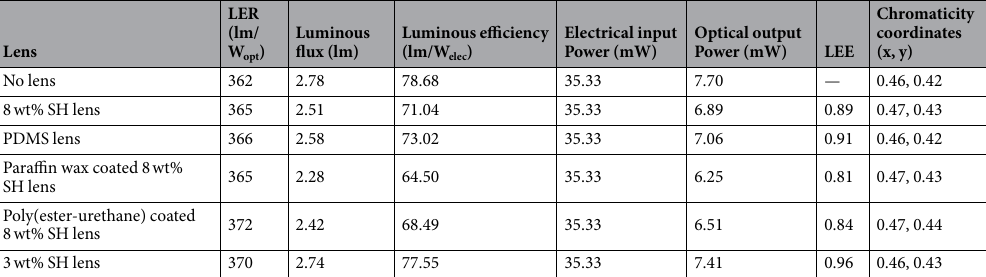
Table 1. Optical parameters of biomaterial lenses on warm white LED. LEE: Light extraction efficiency, SH: silk